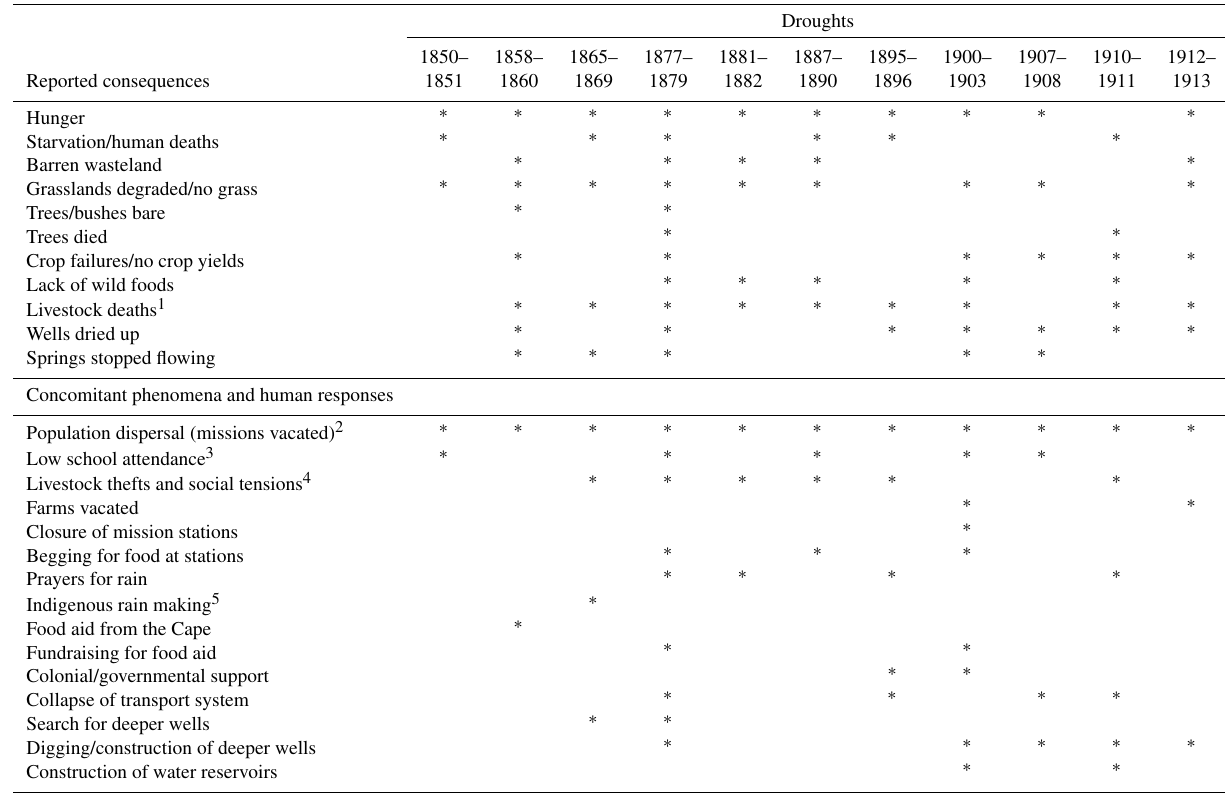
Table 1. Reported consequences, concomitant phenomena, and human responses to droughts between 1850 and 1920 over central